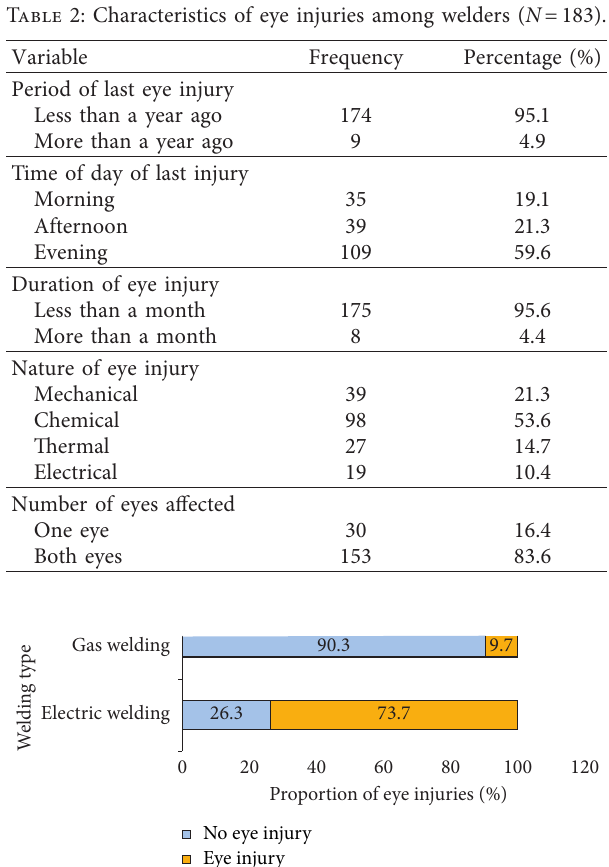
Figure 2: Distribution of self-reported eye injuries among re- spondents based on welding